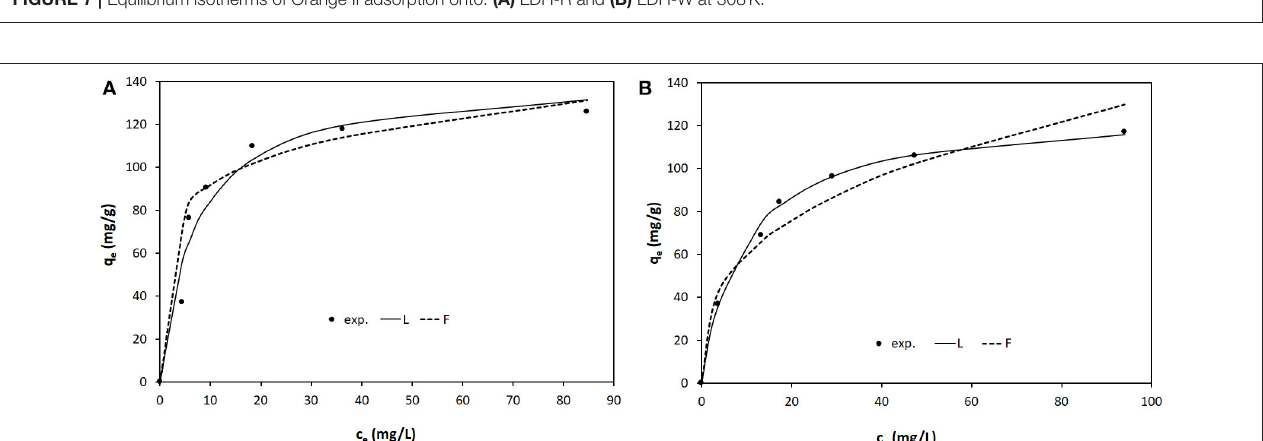
FIGURE 7 | Equilibrium isotherms of Orange II adsorption onto: (A) LDH-R and (B) LDH-W at 308K.